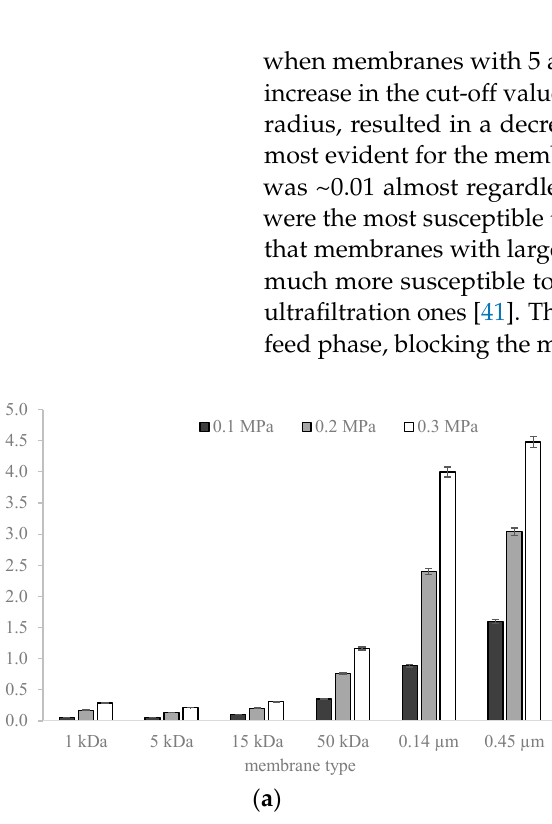
Figure 6. Influence of TMP on membrane permeability of ( a ) redistilled water and ( b ) digestate liquid fraction (after sedimentation pre-treatment).